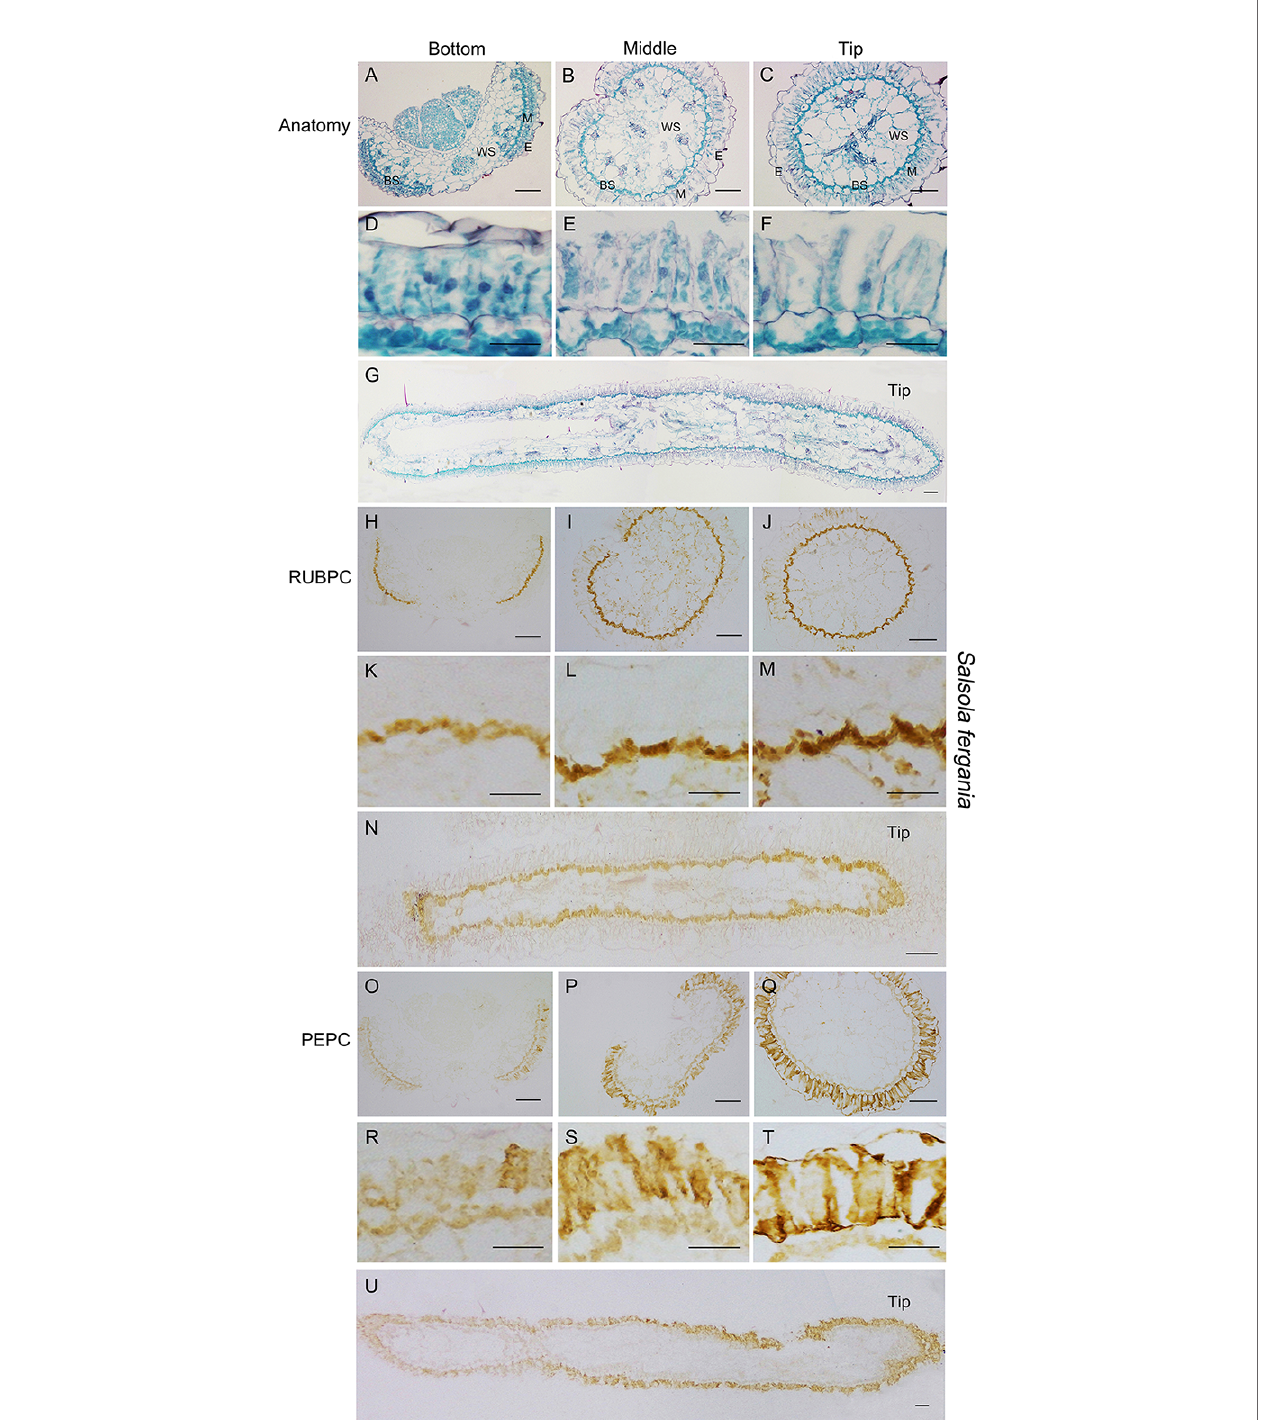
FIGURE 6 | Anatomic structure of leaf and in situ immuno-histochemical localization (ISIHL) of RUBPC and PEPC of S. ferganica with transverse and longitudinal sections of young leaves (0.5 – 0.6 cm), showing a progressive development with gradual structure differentiation. (A – G) Anatomic structure of young leaf; (H – U) ISIHL results; (A – C) Transverse sections from the bottom to tip of leaf; (D – F) Detailed views corresponding to A – C; (G) Longitudinal sections of leaf; (H – J) ISIHL of RUBPC (RBCL) at the bottom, middle, and tip of leaf; (K – M) Detailed views corresponding to H – J; (N) ISIHL of RUBPC (RBCL) of longitudinal direction of leaf; (O – Q) ISIHL of PEPC at bottom, middle, and tip of leaf; (R – T) Detailed views corresponding to O – Q; (U) ISIHL of PEPC of longitudinal direction of leaf. For LS structure of leaf, the tip is on the right. BS, bundle sheath; E, epidermis; H, hypodermis; M, mesophyll; WS, water storage. Scale bar in A – C, G – J, N – Q, U is 100 µm; in D – F, K-M, R – T is 50